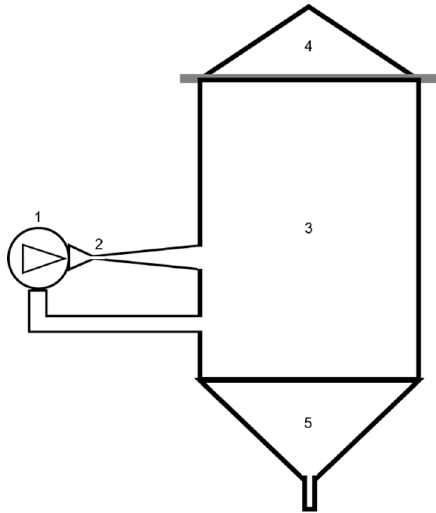
Figure 1. Scheme of the experimental hydrodynamic cavitation-based installation. 1—centrifugal pump, 2—hydrodynamic cavitation (HC) reactor, 3—main vessel, 4—cover, 5—discharge.